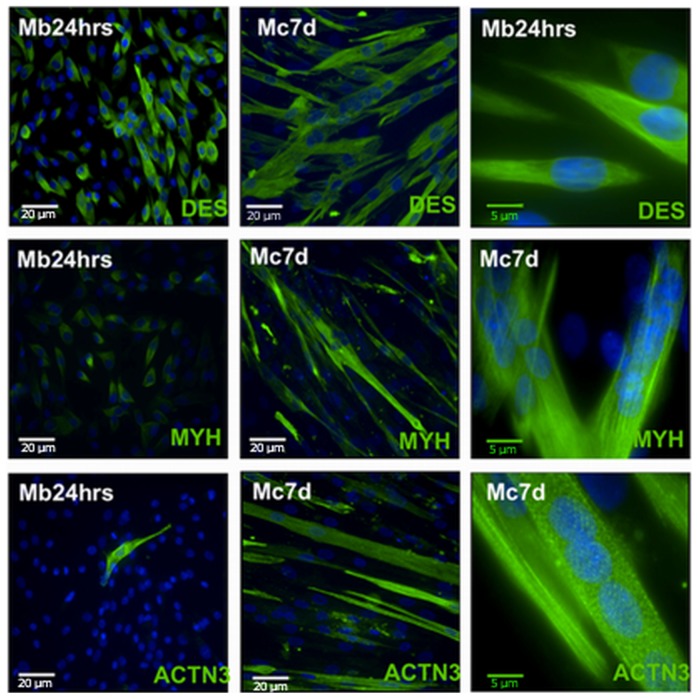
Immunofluorescence analysis of desmin (DES), myosin heavy chain (MYH) and alpha-actinin (ACTN) in myoblasts (Mb24 hrs) and myocytes after 7 days of differentiation (Mc7d).(Magnification in the left and middle columns-200x; in the right column 630x).